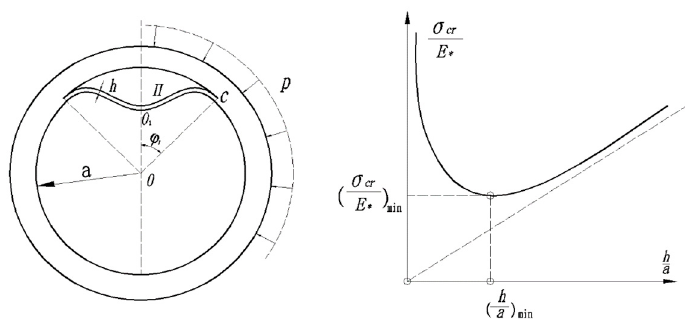
Figure 9. Delamination buckling failure mode and critical load of deep sea thick shell [74].